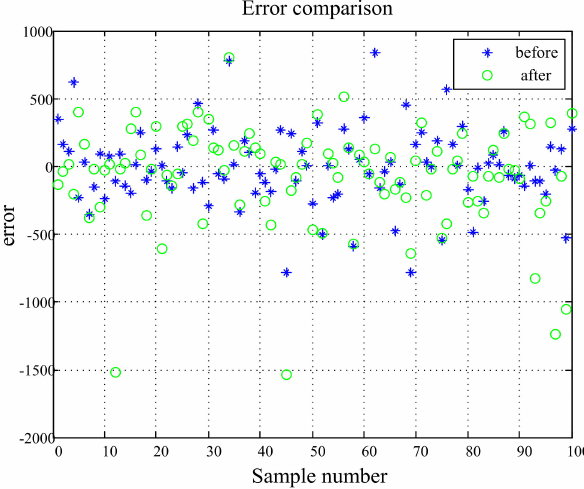
Figure 7. The error of the ELM-KMPE method before and after principal component